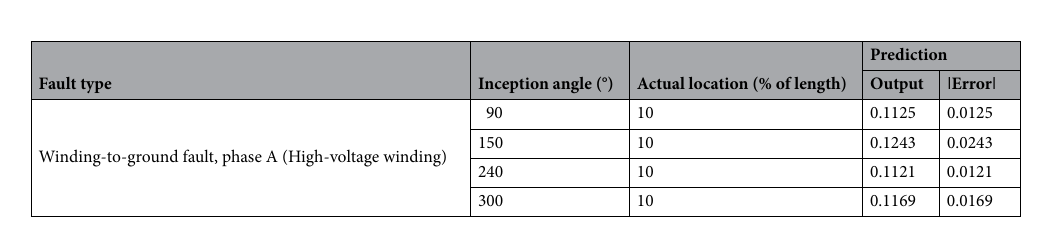
Figure 13. Average error in fault location when algorithm is used with hyperbolic tangent–hyperbolic tangent– linear activation functions.